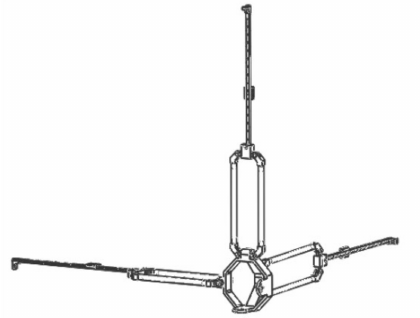
Figure 4. 3PRPaR positioning mechanism